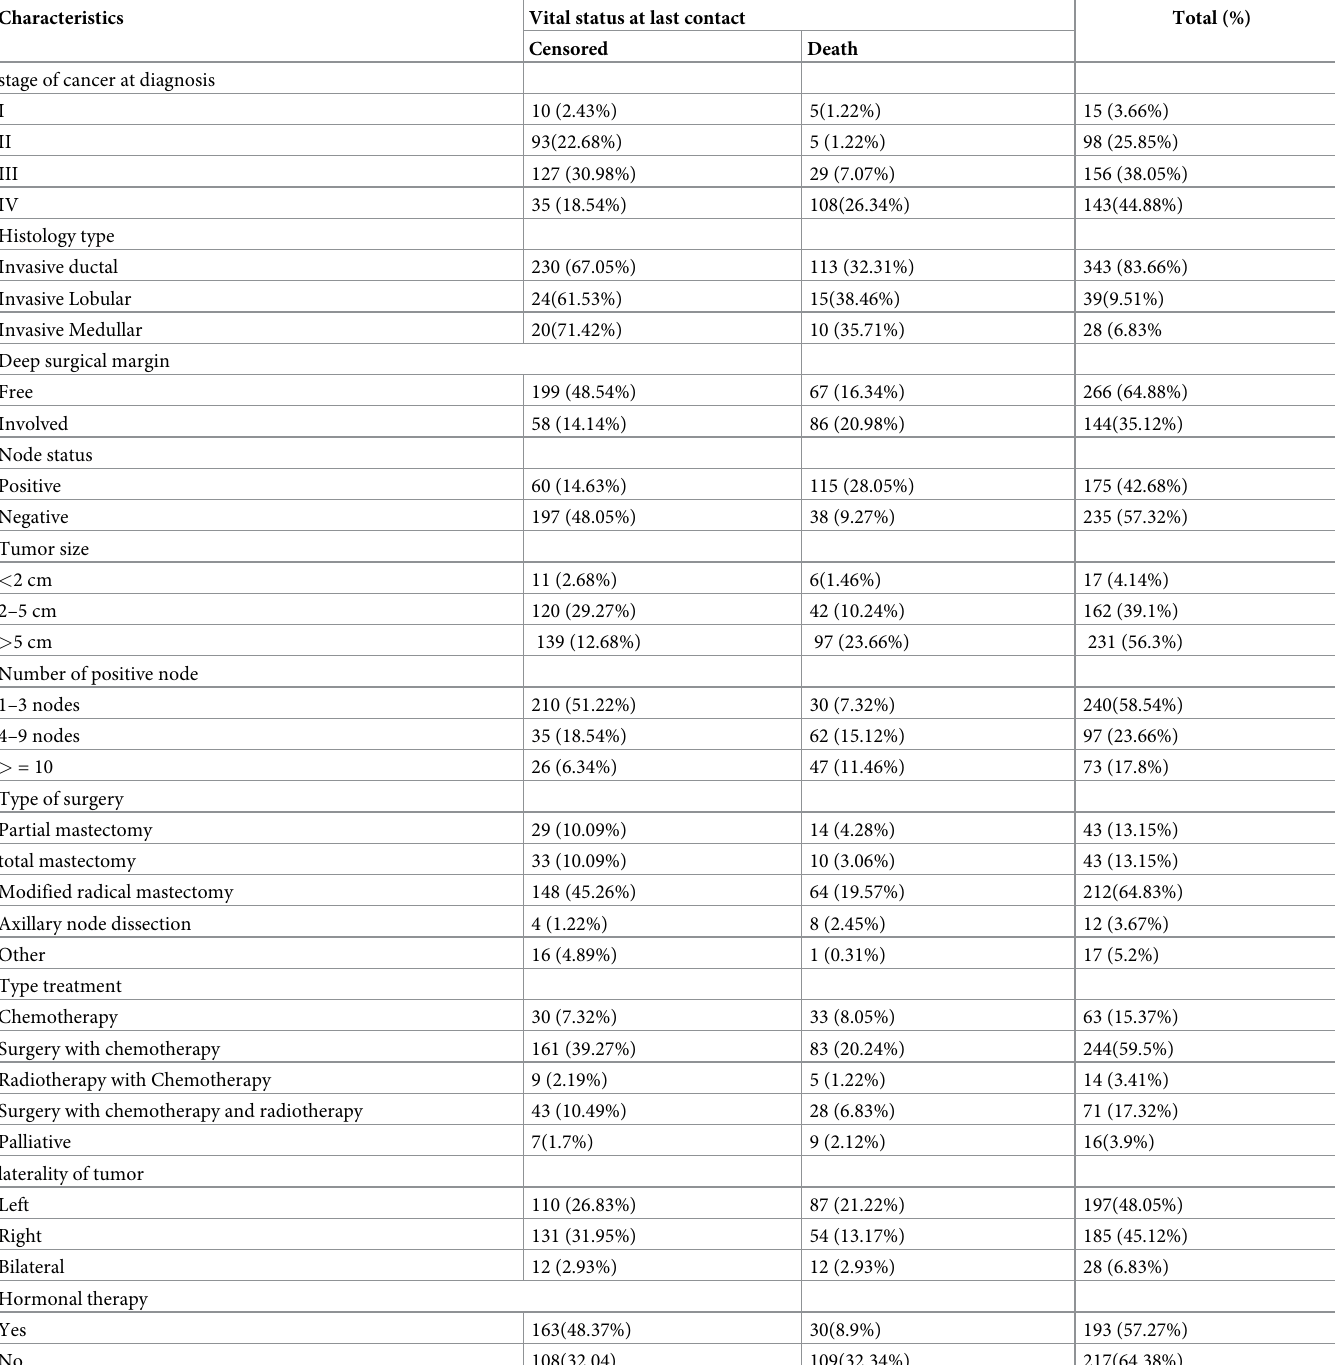
Table 2. Clinical, histopathological, and treatment characteristics of the participants.